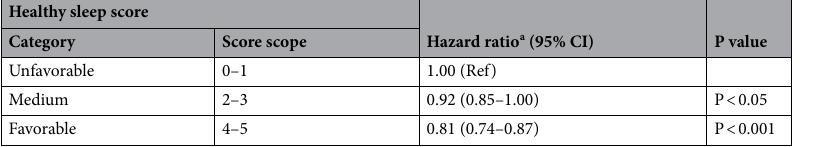
Table 2. Hazard ratio (95% CI) of CRC events according to Sleep Score compared with participants with less than and equal to 1 combined sleep score. 392,252 participants included in the model. a Hazard ratios (95% CI) were adjusted for age, sex, education, family history of CRC, healthy life style